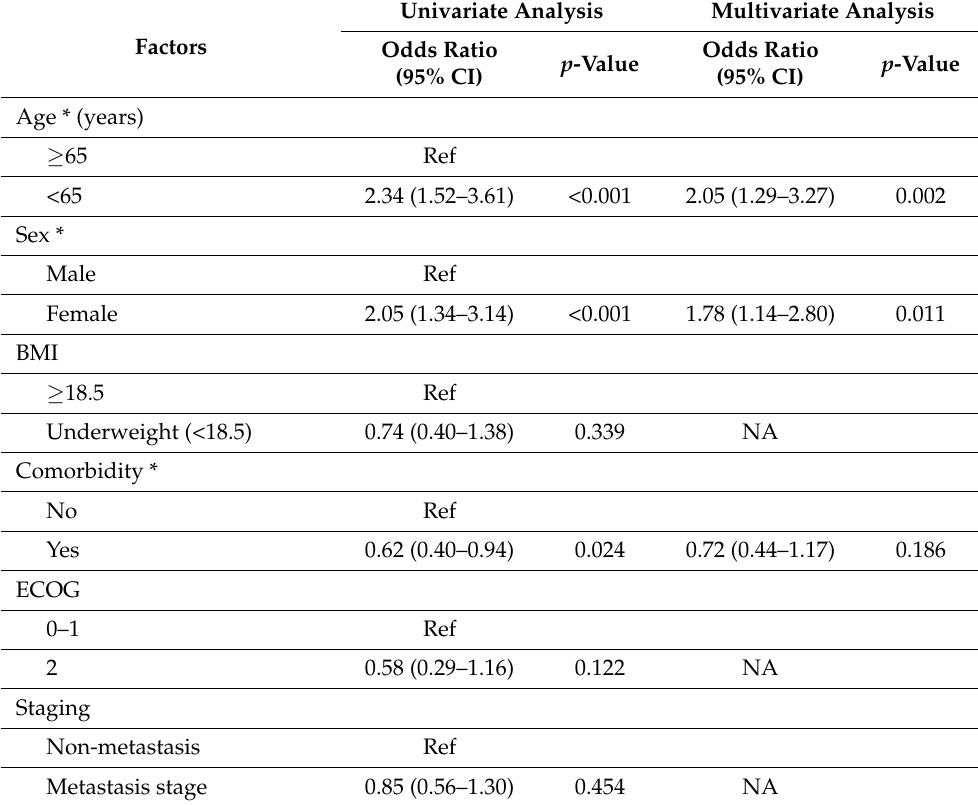
Table 4. Factors associated with local adverse events following the booster dose with the mRNA vaccine.